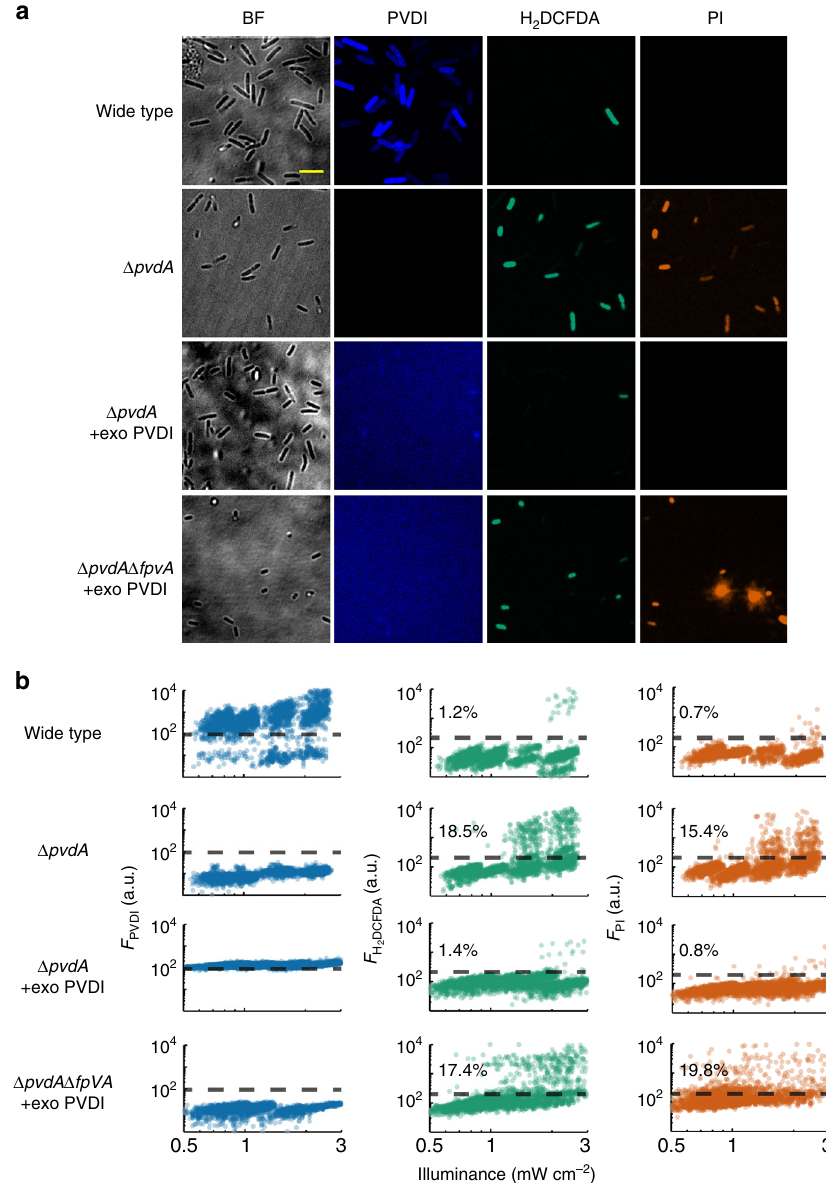
Fig. 2 Accumulation of pyoverdine in bacteria allows them to survive in the presence of environmental stresses. a Representative bright- fi eld (gray) + multi-color confocal images show that the accumulation or the exogenous addition of PVDI (5.0 μ M ) enables wide-type P. aeruginosa or Δ pvdA mutant to survive in the presence of a stronger photon-stress 3 : 00 mWcm (cid:1) 2 ð Þ , where blue, bluish green or vermillion colors represents PVDI, H 2 DCFDA or propidium iodide (PI) fl uorescent intensity respectively, Δ pvdA or Δ pvdA Δ fpvA represents a mutant that de fi cient in production of PVDI or de fi cient in both production of PVDI and uptake of exogenous PVDI, respectively. + exo PVDI represents the exogenous addition of 5.0 μ M PVDI. b Photon-stress dependence of PVDI (blue), H 2 DCFDA (bluish green) or PI fl uorescence intensity (vermillion) in single cells, where the dots present data from single bacteria. Δ pvdA and Δ pvdA Δ fpvA + exo PVDI groups show signi fi cantly higher percentage than that of the wide type group, both for H 2 DCFDA channel and PI channel (one-way RM ANOVA versus wide type data, p < 10 − 6 for Δ pvdA and Δ pvdA Δ fpvA + exo PVDI). Δ pvdA + exo PVDI group shows no signi fi cantly difference with wide type group, both for H 2 DCFDA channel ( p = 0.8054) and PI channel ( p = 0.2557). The black dashed line represents an intensity threshold to distinguish whether the fl uorescence intensities arising from single cells is signi fi cantly greater than the average. Single cells were exposed to light stimulations for 5 hours. Scale bar for all images are 4 μ extracellular and intracellular PVDI, respectively, and μ is the following rate equation to describe the kinetics of the intracellular (cid:1) : growth rate of a cell. Note that (1) exponential growth dilutes the concentration of PVDI ½ PVDI (cid:6) i intracellular concentration of PVDI with the constant of μ and (2) the ratio γ = μ ð Þ of the terms γ ½ PVDI (cid:6) i and μ ½ PVDI (cid:6) i accurately quanti fi es how cells allocate their produced PVDI, in which γ = μ > 1 or γ = μ < 1 indicates that cells prefer to secrete or reserve where ½ PVDI (cid:6) o is the extracellular concentration of PVDI, P is the PVDI molecules produced by themselves, respectively. To directly productivity of PVDI, a and γ are the uptake and ef fl ux rates of